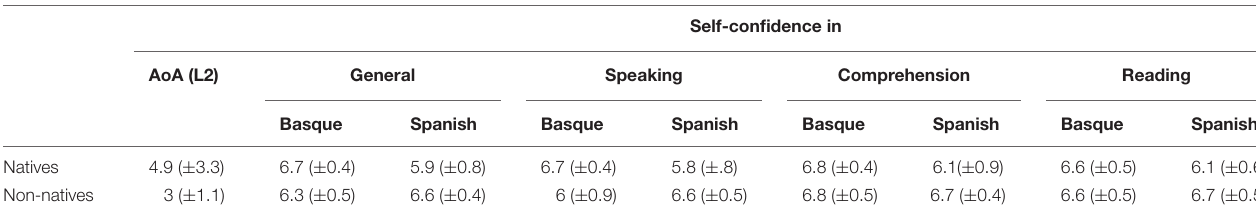
TABLE 1 | Comparative between the characteristics of Basque natives’ and non-natives’ sample.